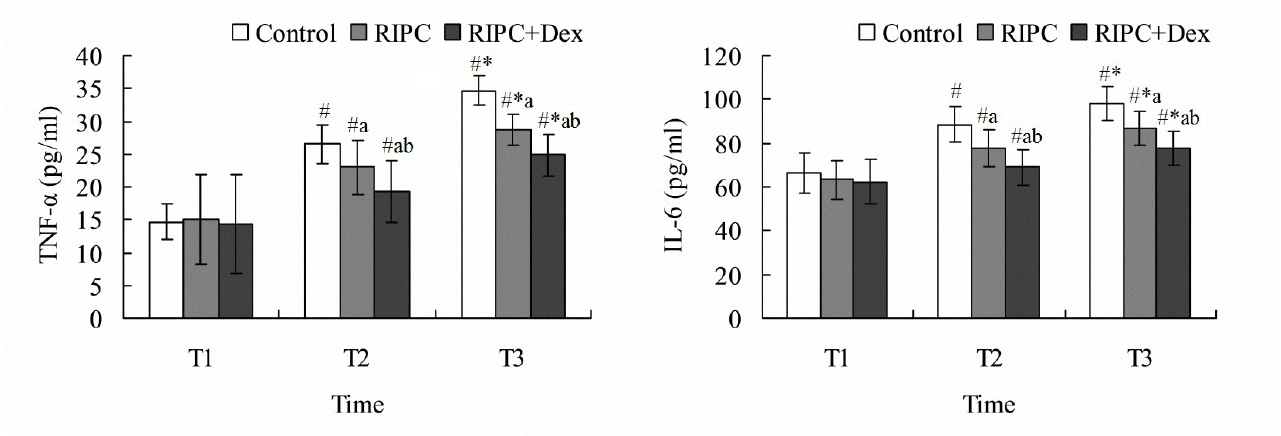
FIGURE 3 - Comparison of serum TNF-α and IL-6 levelsamong three groups. # P < 0.05 compared with T1; * P < 0.05 compared with T2; a P < 0.05 compared with control group; b P < 0.05 compared with RIPC group. TNF-α, tumor necrosis factor α; IL-6, interleukin